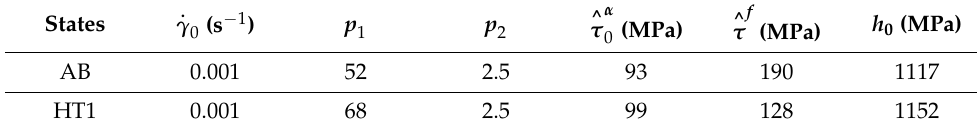
Table 3. Optimized CP parameters for Al determined by inverse analysis. See text for details.